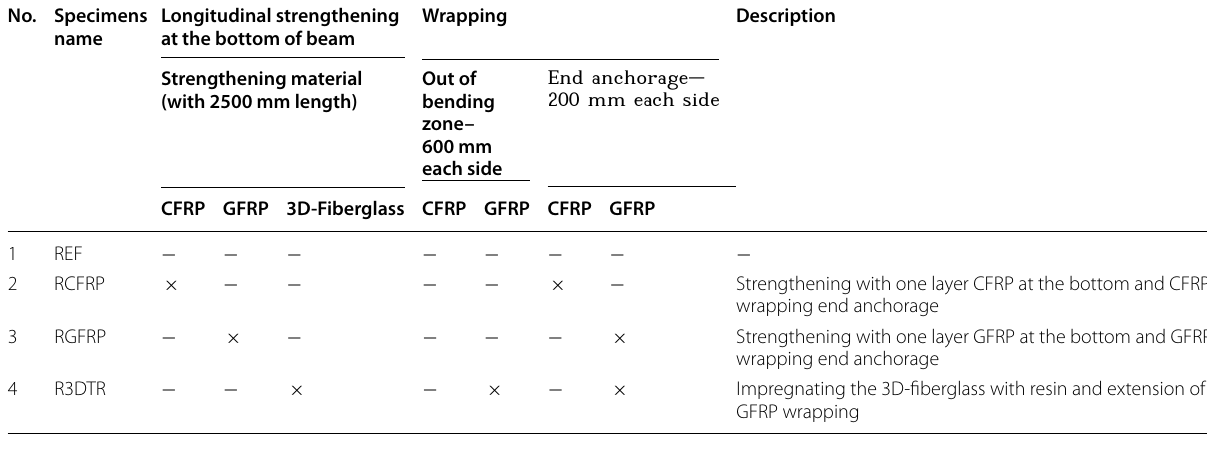
Table 1 Nomenclature of the four initial tested beams: REF, RCFRP, RGFRP and R3DTR. No. Specimens name